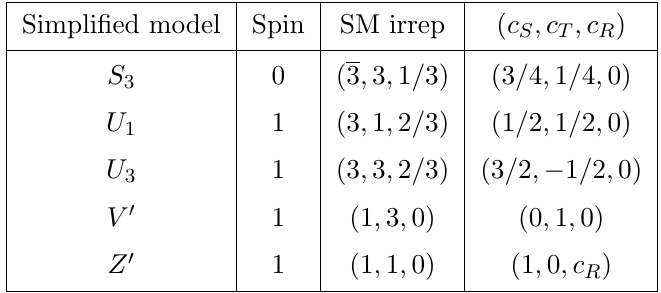
Table 5 . Wilson coe(cid:14)cients ratios (cf. eq. (3.4)) for some single-mediator simpli(cid:12)ed